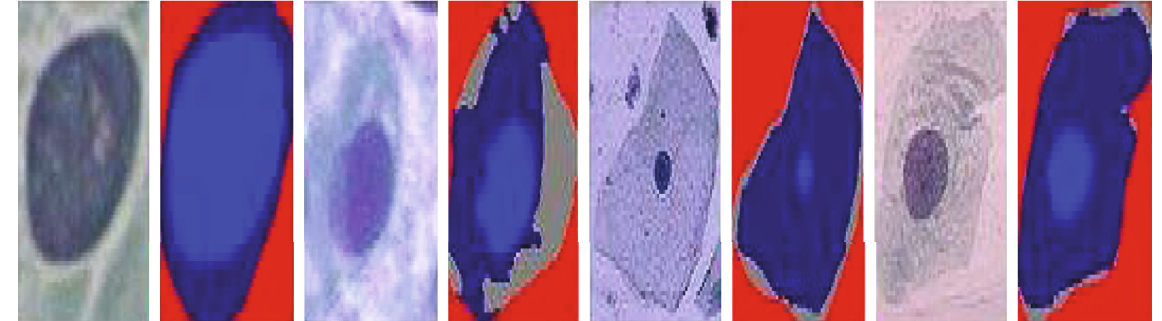
Figure 3: Images from the datasets [24,